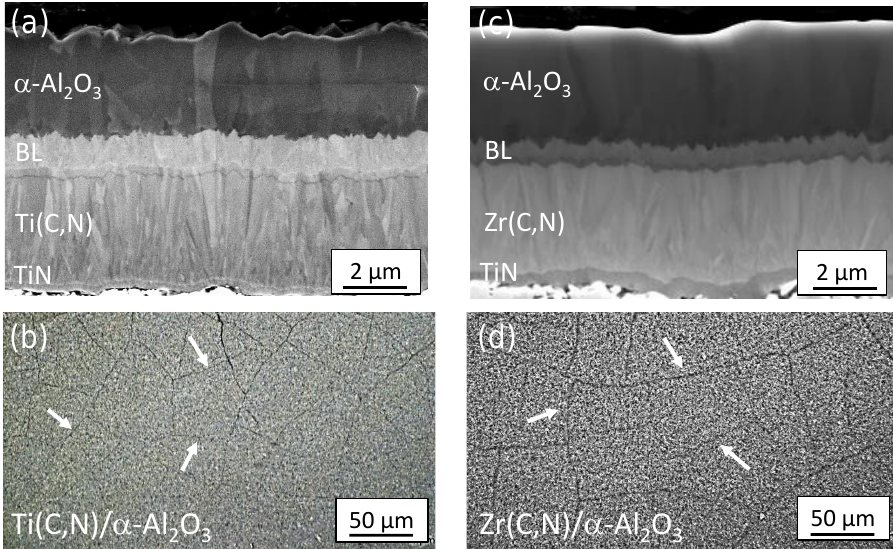
Figure 1. ( a , c ) SEM images of as-coated systems investigated (polished cross-sections) ( b , d ) LOM top-view images for the Figure 1. ( a , b ) SEM images of as-coated systems investigated (polished cross-sections) ( c , d ) LOM top-view images for the as-coated condition showing α-Al 2 O 3 outer layer. White arrows indicate as-coated condition showing α -Al 2 O 3 outer layer. White arrows indicate CVD crack CVD crack network. Table 1. Elastic and thermal properties for the substrate and coating materials [13–16]. Substrate/ Coating Layer